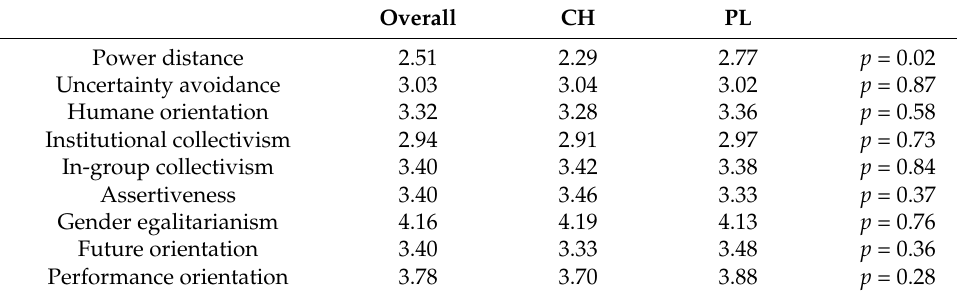
Figure 3. Relative importance vs. experience by manager country (Polish employees). Table 7. Cultural dimensions—scores in Switzerland and